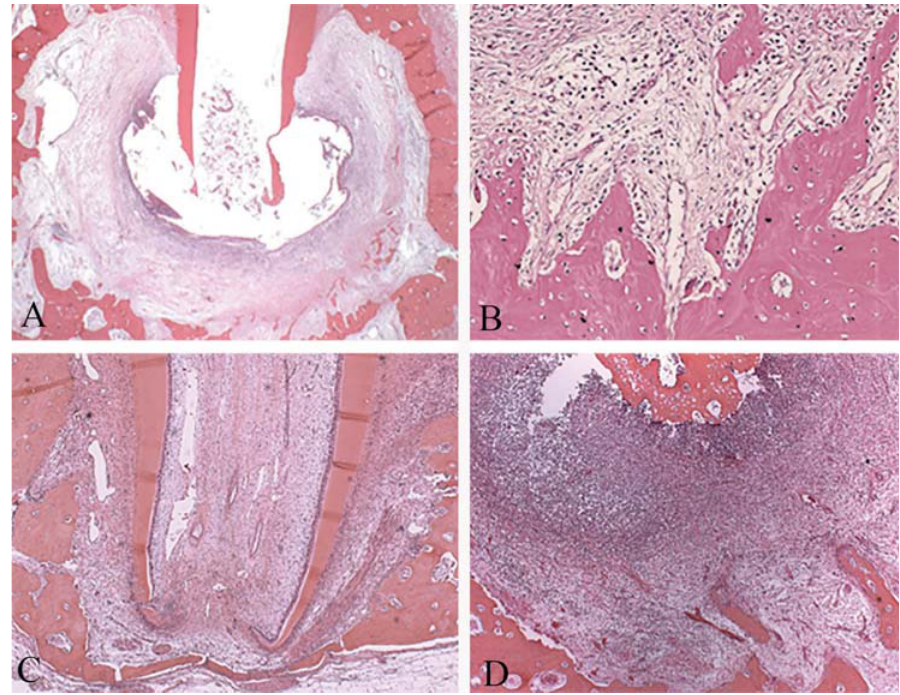
Figure 2- Representative photomicrographs of the conventional, healthy, and apical periodontitis groups, 90 days after the endodontic treatment, in conventional light microscopy: (A) Panoramic view of the apical and periapical regions of the conventional group showing an increased periodontal ligament (HE, Zeiss, 1.25X). (B) Detail of the alveolar bone of the conventional group with no osteoblast in its surface and presence of osteoclast (HE, Zeiss, 20X). (C) Panoramic view of the healthy teeth group with incomplete root formation, normal pulp, and an odontoblastic layer. Periodontal ligament and alveolar bone were healthy (HE, Zeiss, 10X). (D) Panoramic view of the apical (cid:83)(cid:72)(cid:85)(cid:76)(cid:82)(cid:71)(cid:82)(cid:81)(cid:87)(cid:76)(cid:87)(cid:76)(cid:86)(cid:3)(cid:74)(cid:85)(cid:82)(cid:88)(cid:83)(cid:3)(cid:86)(cid:75)(cid:82)(cid:90)(cid:76)(cid:81)(cid:74)(cid:3)(cid:68)(cid:3)(cid:73)(cid:82)(cid:70)(cid:68)(cid:79)(cid:3)(cid:86)(cid:72)(cid:89)(cid:72)(cid:85)(cid:72)(cid:3)(cid:76)(cid:81)(cid:192)(cid:68)(cid:80)(cid:80)(cid:68)(cid:87)(cid:82)(cid:85)(cid:92)(cid:3)(cid:76)(cid:81)(cid:191)(cid:79)(cid:87)(cid:85)(cid:68)(cid:87)(cid:72)(cid:3)(cid:11)(cid:43)(cid:40)(cid:15)(cid:3)(cid:61)(cid:72)(cid:76)(cid:86)(cid:86)(cid:15)(cid:3)(cid:24)(cid:59)(cid:12)(cid:17)(cid:3)(cid:43)(cid:40)(cid:3)(cid:32)(cid:3)(cid:75)(cid:72)(cid:80)(cid:68)(cid:87)(cid:82)(cid:91)(cid:92)(cid:79)(cid:76)(cid:81)(cid:3)(cid:9)(cid:3)(cid:72)(cid:82)(cid:86)(cid:76)(cid:81)